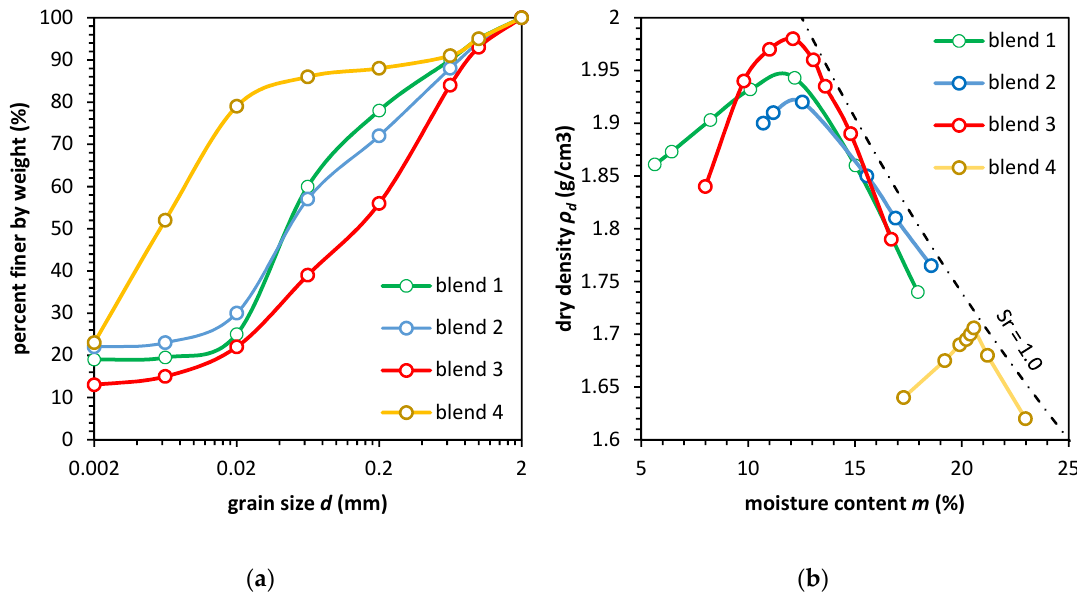
Figure 2. The physical properties of cohesive material in this study. ( a ) Soil gradation curve; ( b ) Optimal moisture test results following the Proctor method for four soil types.